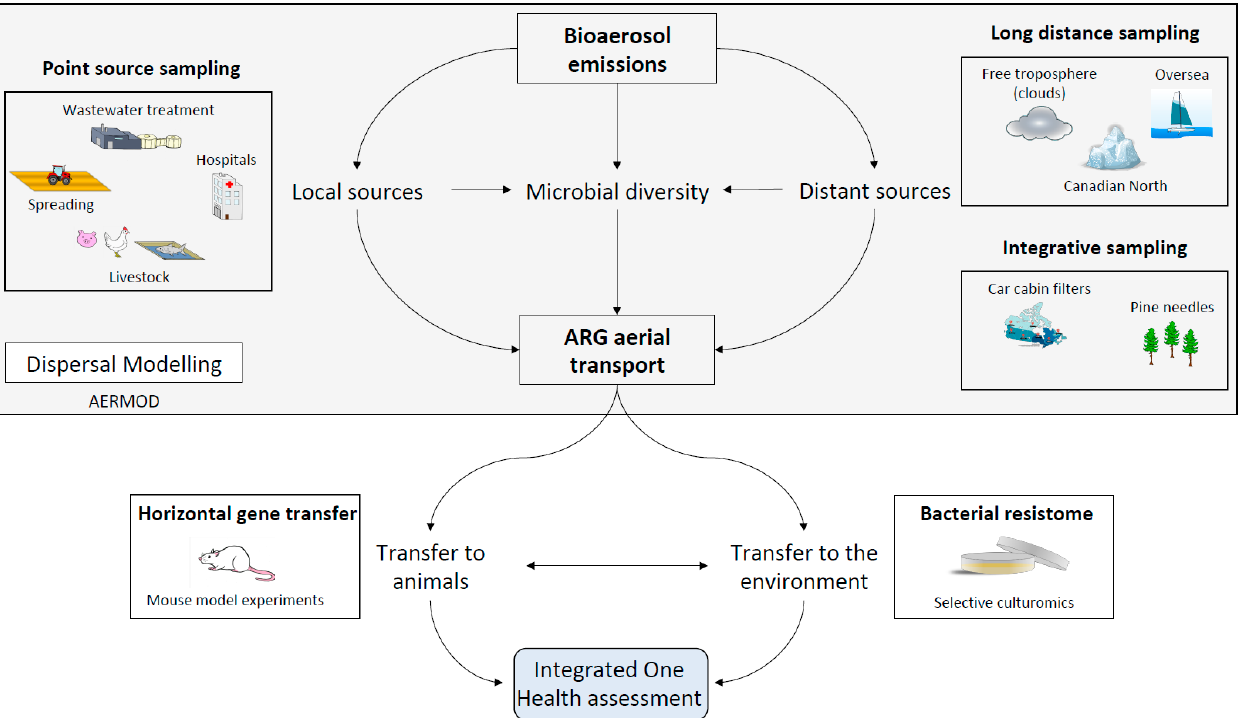
Figure 2. Conceptual diagram showing the creation of ARG risk assessment models. Data